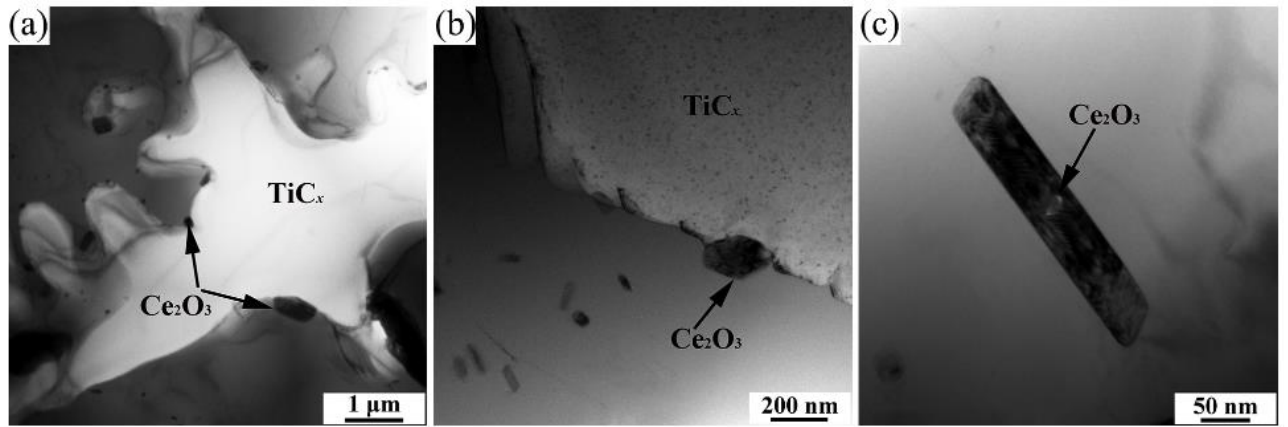
Figure 7. TEM images of different precipitates in the coating with 2 wt.% CeO 2 : ( a ) Ce 2 O 3 and TiC x ; ( b ) CrTi 4 and Ce 2 O 3 ; ( c ) CeO 2 .